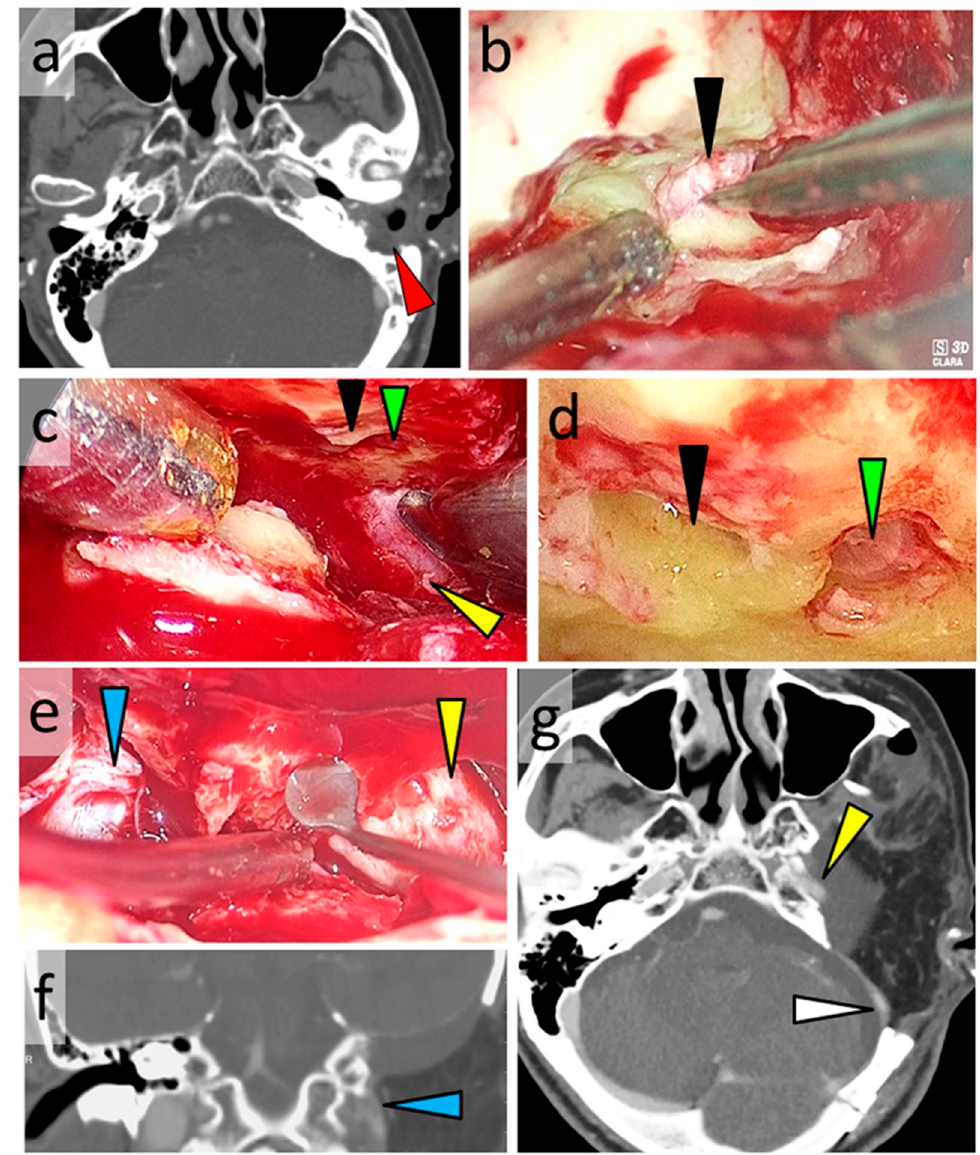
Figure 8. CT images and photographs of Case 2. Subtotal temporal bone resection performed in a patient with external auditory canal squamous cell carcinoma. ( a ) Preoperative axial CT image showing left external auditory canal carcinoma involving the temporomandibular joint, tympanic cavity, and mastoid air cells. ( b ) Intraoperative exoscopic photographs showing the opened internal auditory canal (black arrowhead). ( c – e ) Intraoperative endoscopic photographs. ( c ) The carotid canal is opened following the transection of the internal auditory canal (black arrowhead) and cochlea (green arrowhead). Yellow arrowhead: the internal carotid artery. ( d ) The 30° angled endoscopic photograph showing the cut end of the internal auditory canal (black arrowhead) and cochlea (green arrowhead). ( e ) The lateral wall of the carotid canal (yellow arrowhead) and jugular foramen (blue arrowhead) are carefully dissected. ( f ) Postoperative coronal CT image. Blue arrowhead: opened jugular foramen. ( g ) Postoperative axial CT image. Yellow arrowhead: opened carotid canal. White arrowhead: sigmoid sinus. CT, computed tomography.